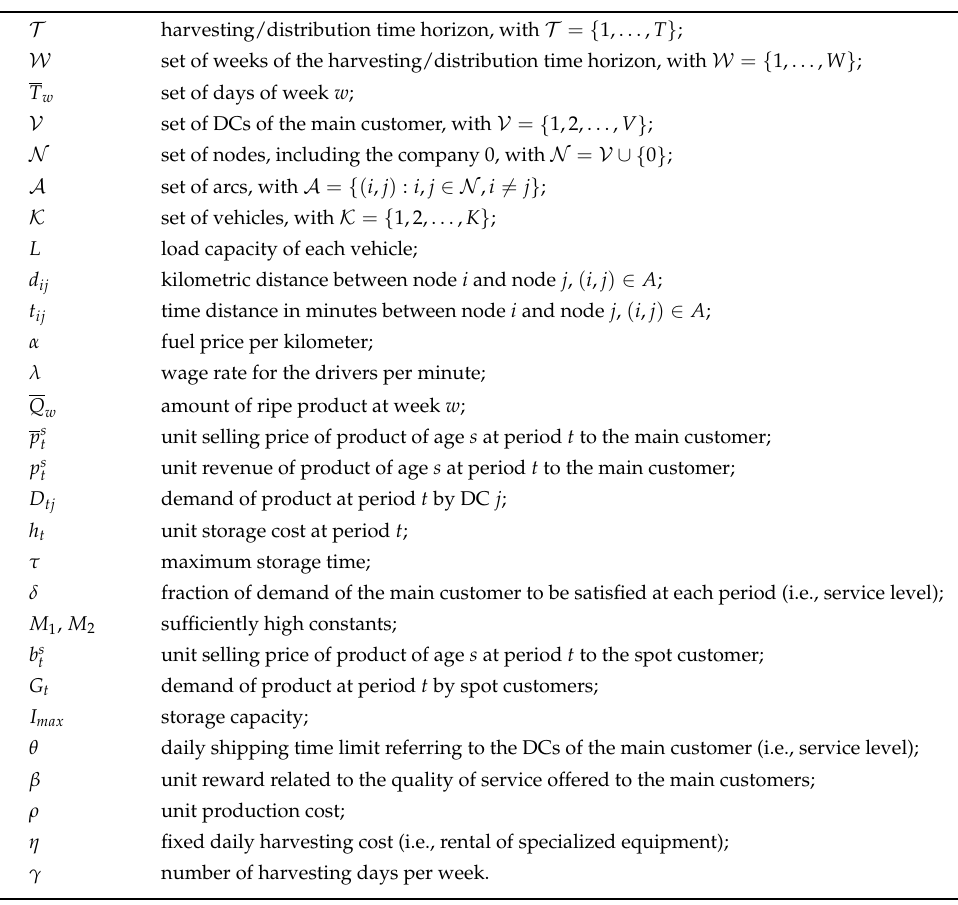
Table 1. Notation: problem data.